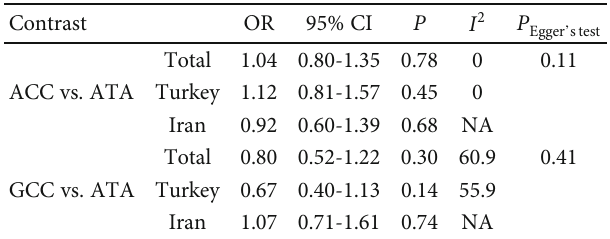
Figure 4: Statistical analysis of the association between IL-10 -592A > C polymorphism and BD risk in the C vs. A model. (a) ORs and 95% CIs; (b) cumulative analysis; (c) sensitivity analysis; (d) publication bias. Table 4: Meta-analysis of the IL-10 -1082A > G, -819T > C and -592A > C haplotype and BD